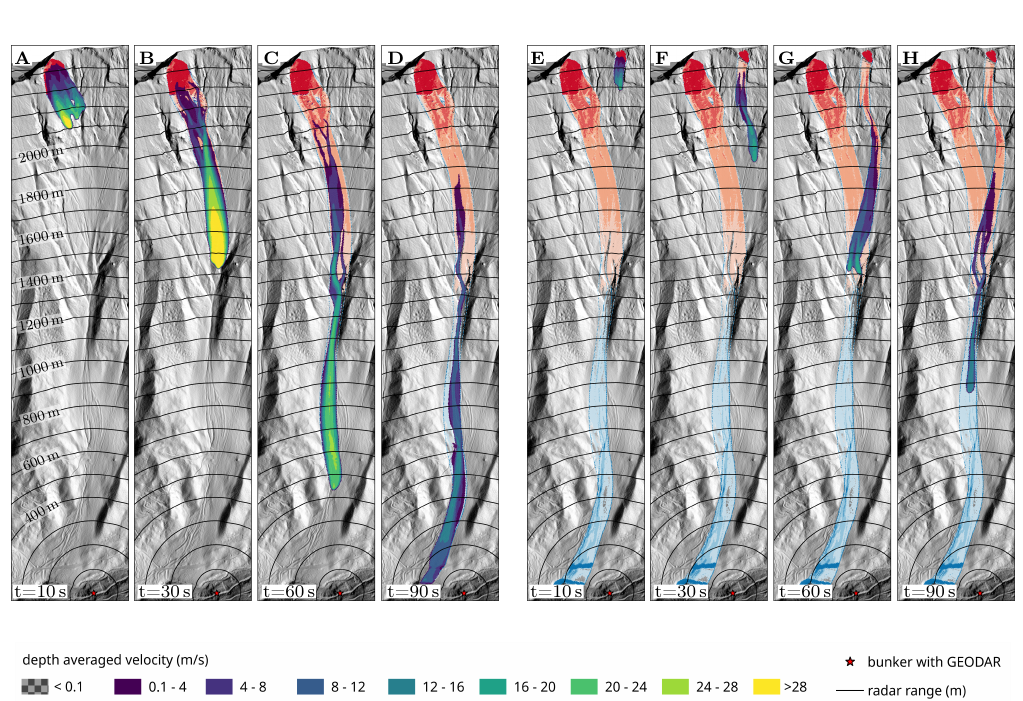
Figure 6. Time series of the simulation for avalanche #0017 ( A – D ) and #0019 ( E – H ) at 10, 30, 60 and 90s. Concentric circles mark the line-of-sight distance from the bunker giving the radar range. The flowing avalanche is indicated with the depth-averaged velocity u . In the background, snow cover changes due to entrainment (red) and deposition (blue) are indicated with the same colour scale as the simulated mass balance in Figure